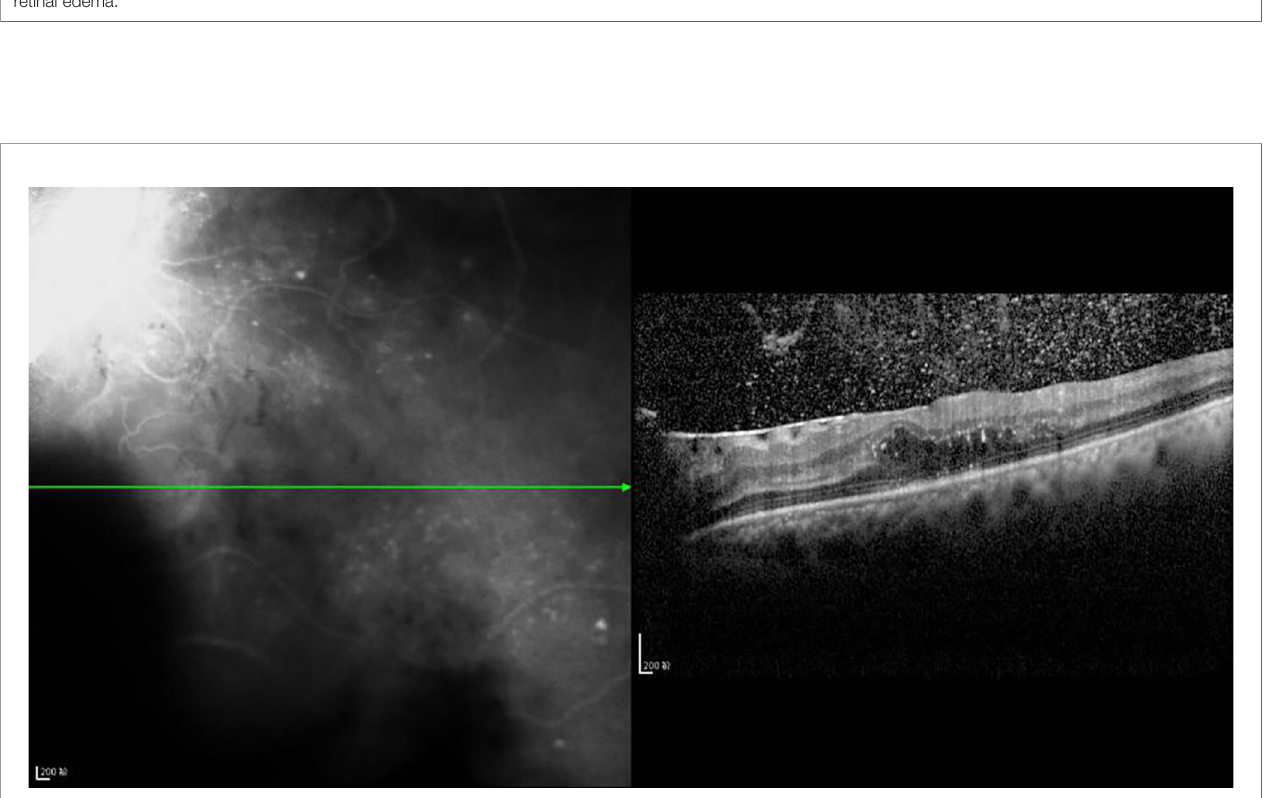
FIGURE 7 | The CFT value is 437 m m, the fracture distance of the ELM layer is 897 m m, the fracture distance of the IS/OS layer is 977 m m, and there is mixed retinal edema.